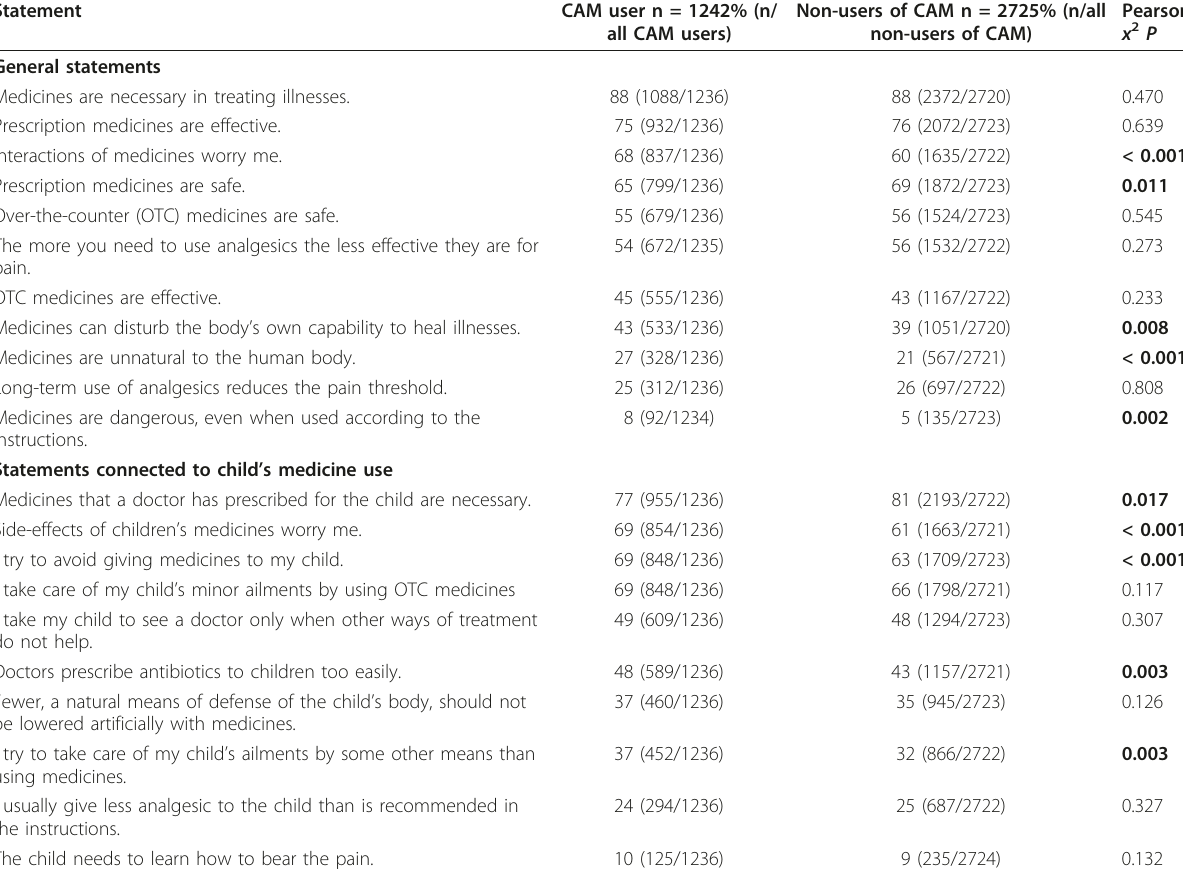
Table 3 The proportion users and non-users of CAM who agree* with the statements (n = 4032) (significant p-values in